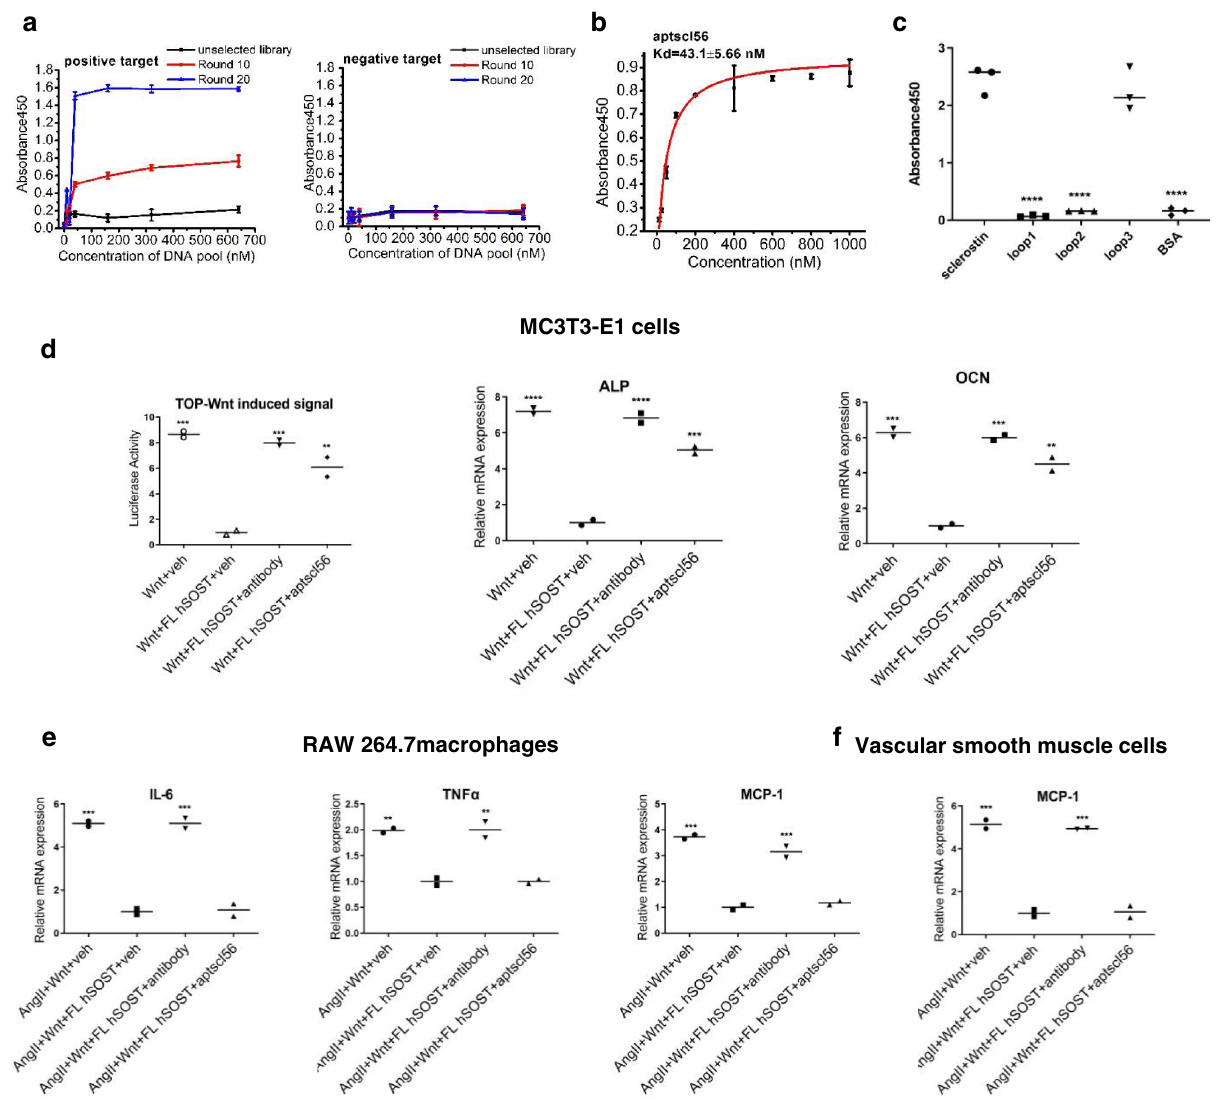
Fig. 4 Selection and characterization of aptamer candidates against sclerostin loop3. a The binding ability of the enriched ssDNA pools and unselected library to full-length sclerostin (left) and loop3-de fi cient sclerostin (right). b The binding af fi nity of aptscl56 to full-length sclerostin. c The binding ability of aptscl56 to full-length sclerostin and sclerostin loops. One-way ANOVA with Tukey ’ s post-hoc test vs . FL hSOST was used to determine the intergroup differences. **** p < 0.0001 . p < 0.0001 (loop1, loop2, BSA). For ( a to c ), data were expressed as the mean ± standard deviation. n = 3 per group. d The effect of aptscl56 on regulating Wnt signalling and osteogenic potential in MC3T3-E1 cells. One-way ANOVA with Tukey ’ s post-hoc test vs . Wnt + FL hSOST + veh (TOP-Wnt-induced signal) or vs. Wnt + FL hSOST + veh (ALP and OCN) was used to determine the intergroup differences. TOP-Wnt-induced signal: p = 0.0005 (Wnt + veh), p = 0.0007 (Wnt + FL SOST + antibody), p = 0.0024 (Wnt + FL SOST + aptscl56); ALP: p < 0.0001 (Wnt + veh, Wnt + FL SOST + antibody), p = 0.0003 (Wnt + FL SOST + aptscl56); OCN: p = 0.0003 (Wnt + veh), p = 0.0003 (Wnt + FL SOST + antibody), p = 0.0012 (Wnt + FL SOST + aptscl56). e The effect of aptscl56 on regulating mRNA levels of IL-6, TNF α and MCP-1 in RAW264.7 macrophages with AngII treatment. IL-6: p = 0.0004 (AngII + Wnt + veh), p = 0.0004 (AngII + Wnt + FL SOST + antibody); TNF- α : p = 0.0036 (AngII + Wnt + veh), p = 0.0034 (AngII + Wnt + FL SOST + antibody); MCP-1: p = 0.0003 (AngII + Wnt + veh), p = 0.0007 (AngII + Wnt + FL SOST + antibody). f The effect of aptscl56 on regulating the mRNA level of MCP-1 in VSMCs with AngII treatment. p = 0.0002 (AngII + Wnt + veh), p = 0.0003 (AngII + Wnt + FL SOST + antibody). For ( e , f ), one-way ANOVA with Tukey ’ s post - hoc test vs. FL hSOST + AngII + veh was used to determine the intergroup differences. For ( d – f ), data were expressed as the mean ± standard deviation. n = 2 per group. * p < 0.05; ** p < 0.01; *** p < 0.005; **** p < 0.0001. Note: ALP: alkaline phosphatase; OCN: osteocalcin; AngII: angiotensin II; IL-6: interleukin 6; MCP-1: monocyte chemoattractant protein-1; TNF- α : tumour necrosis factor alpha. Source data are provided as a Source Data fi Wnt and FL hSOST, followed by treatment with vehicle, aptscl56 than in cells treated with vehicle (Fig. 4d). These data demon- strated that targeting sclerostin loop3 with aptscl56 could attenuate the antagonistic effect of sclerostin on Wnt signalling to promote osteogenic potential in MC3T3-E1 cells. RAW264.7 macrophages and VSMCs were treated with conditioned media from the MC3T3-E1 cells transfected with